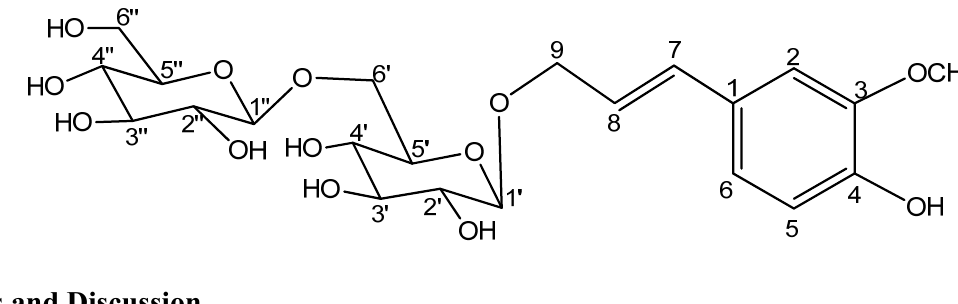
Figure 1. Structure of compound 1 .